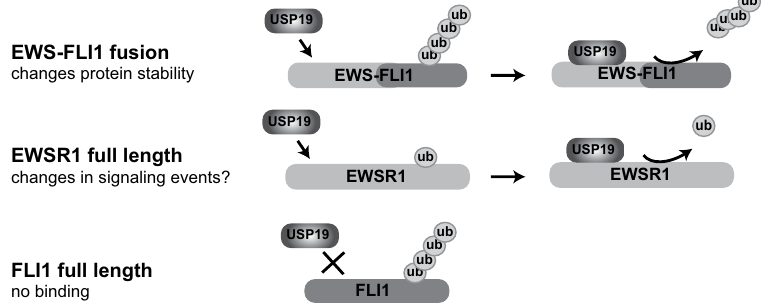
Figure 6. USP19 selectively stabilizes EWS-FLI1. ( a ) USP19 binds to the EWS-FLI1 fusion protein which is further deubiquitinated. ( b ) USP19 also binds to the stable EWSR1 full length protein resulting in removal of the monoubiquitin. As USP19 does not bind to full length FLI1, its polyubiquitination pattern is